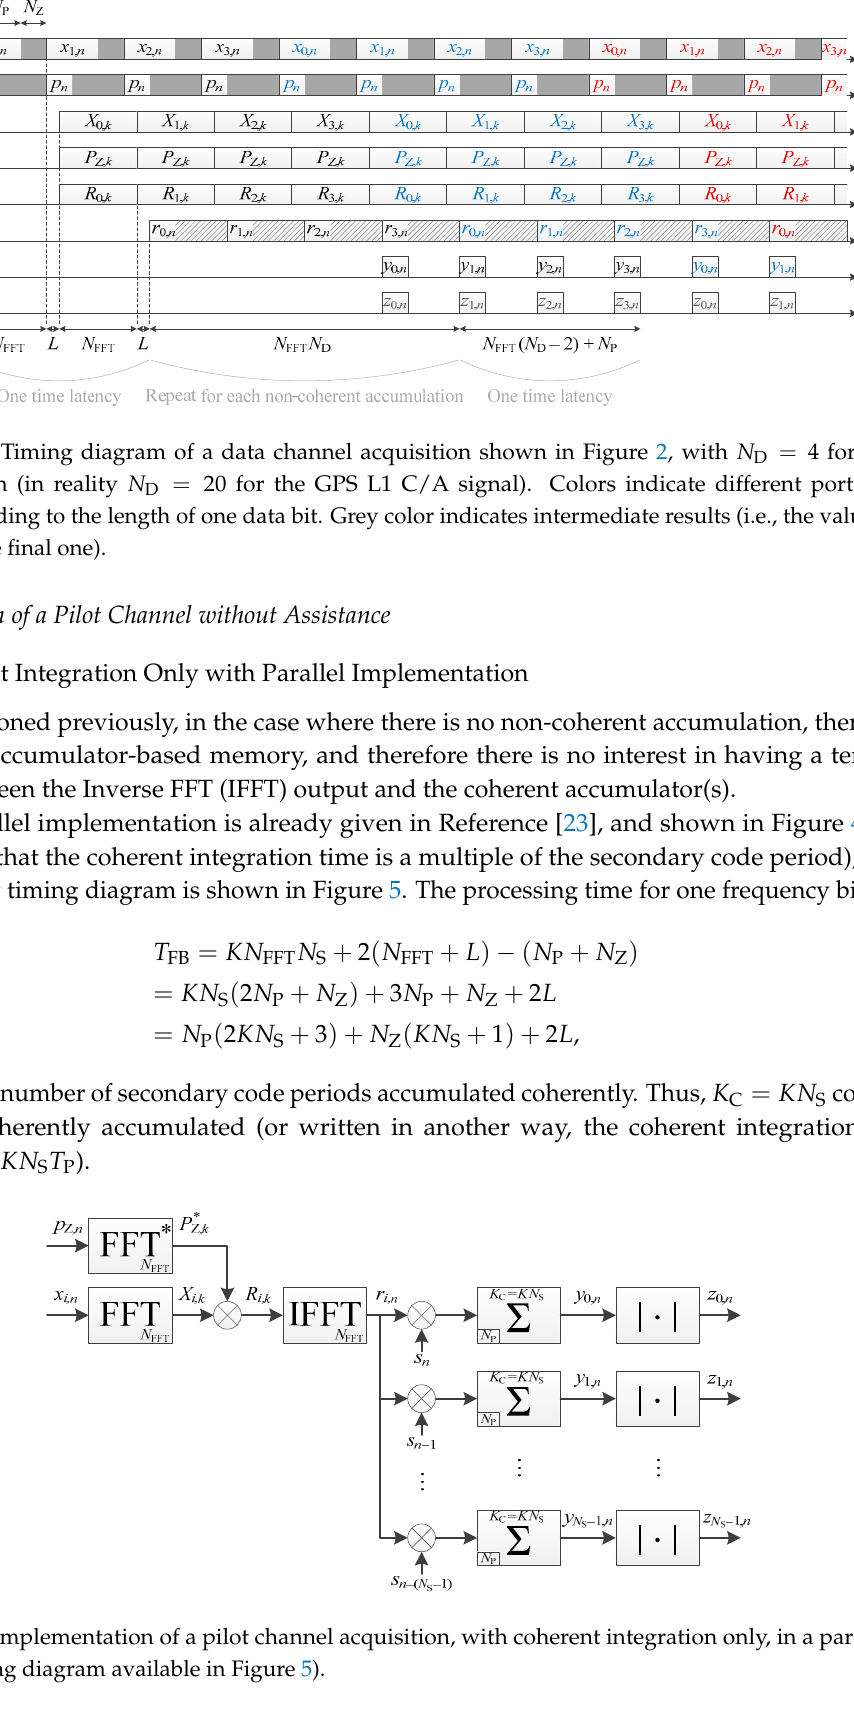
Figure 2. Implementation of a data channel acquisition (timing diagram available in Figure 3).